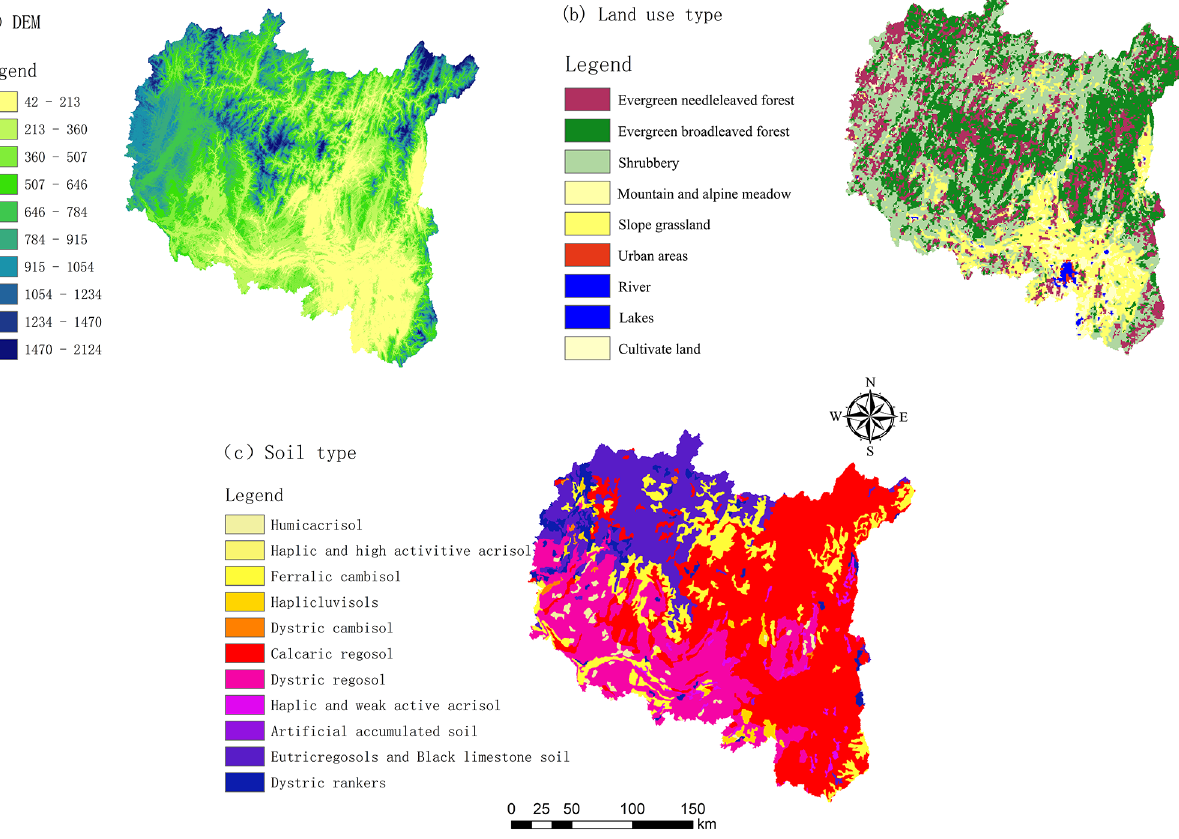
Figure 2. Terrain properties of LRB.